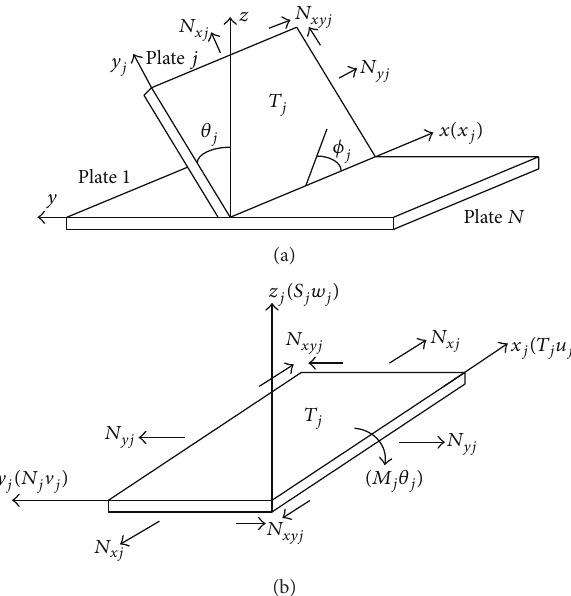
Figure 1: (a) Schematic of plate junction in thermal environments. (b) Coordinate system, displacements, tractions, temperature, and thermal stresses of plate 𝑗